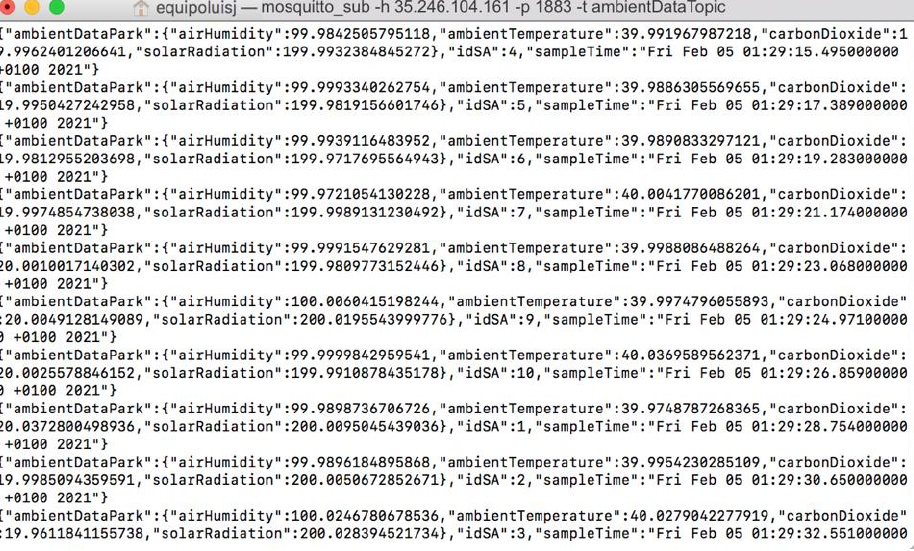
Figure 22. Data Monitor.